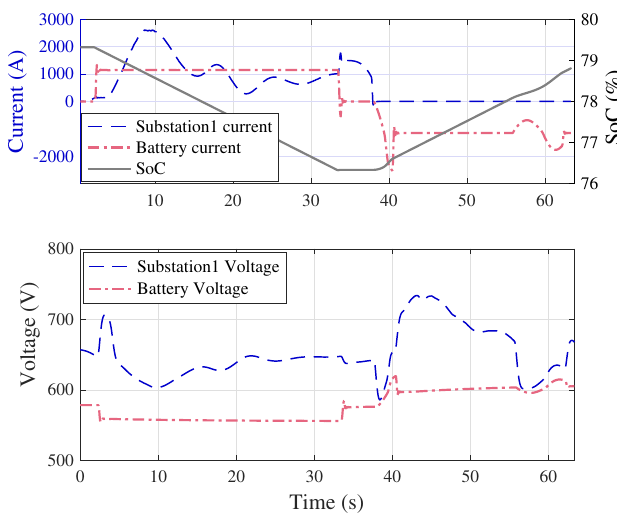
Figure 14. Substation1 and Battery Current, Battery SoC, Substation1, and Battery Voltage for 15% energy saving with standalone